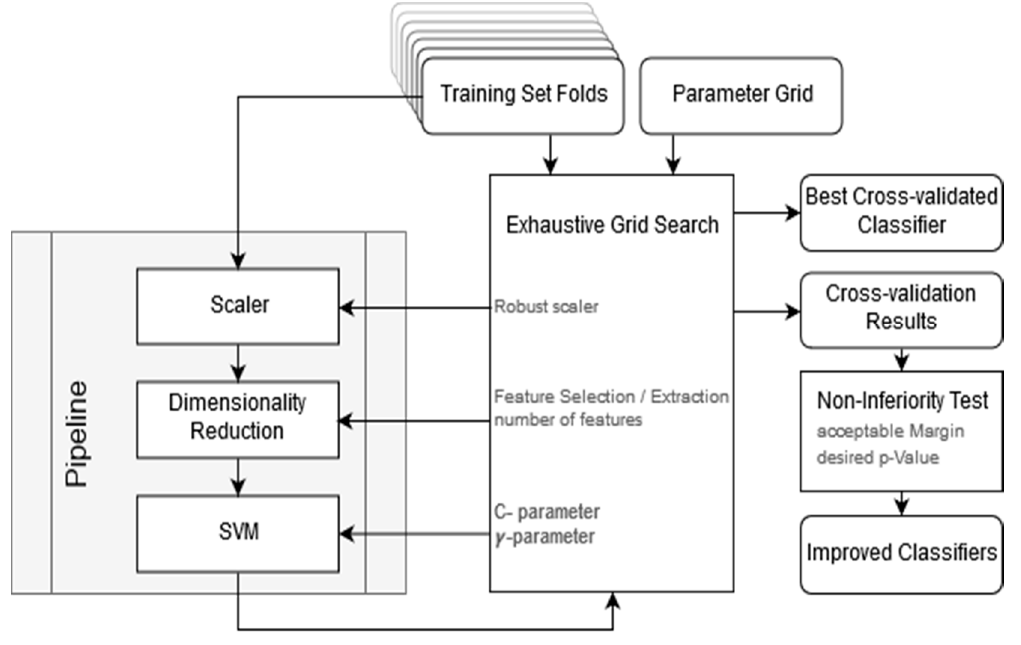
Figure 4. Features selection and classifier optimization workflow.